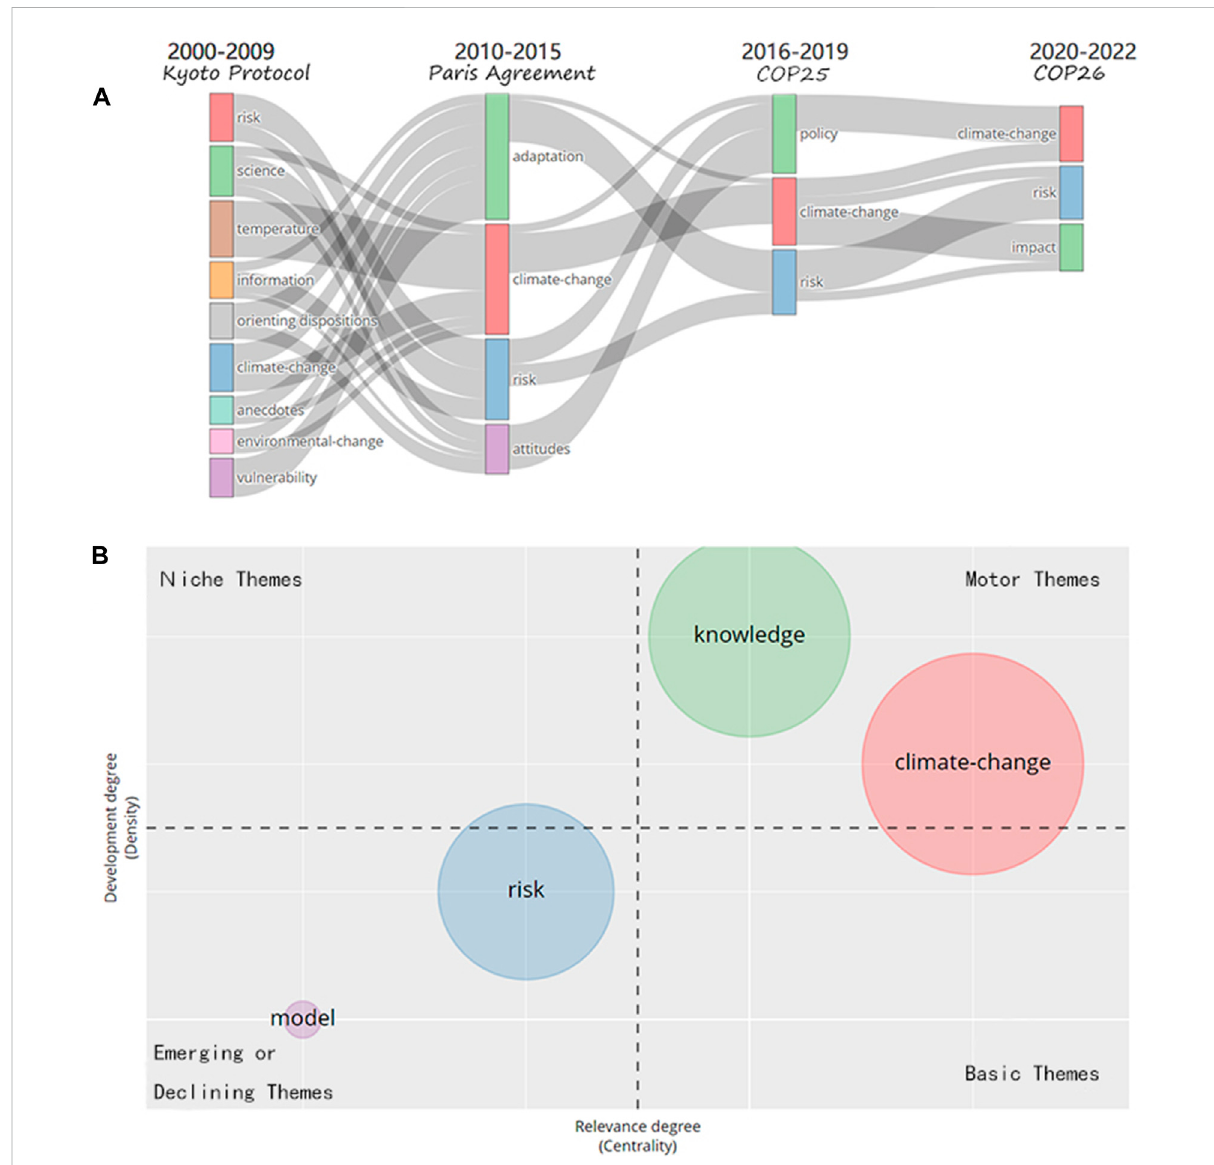
FIGURE 4 The change in the themes at different times during the period 2000-2022 (A); status and development trend of different themes during the period 2016-2022 (B)